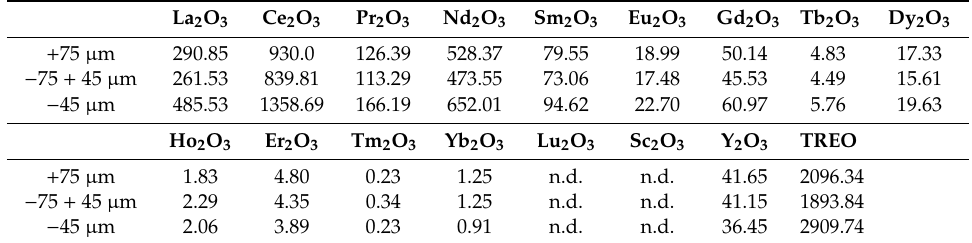
Table 5. The individual REEs concentrations of in the size fractions of +75, − 75 + 45 and − 45 µm in the PG (mg/kg).